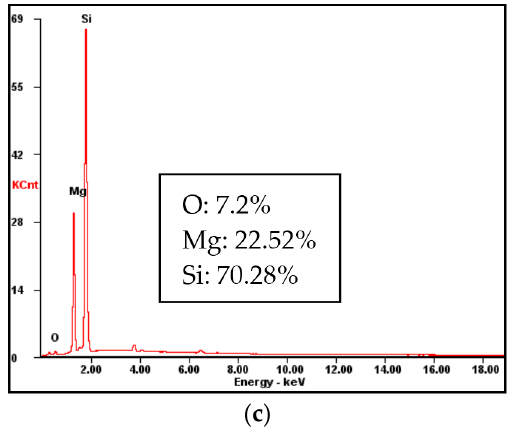
Figure 7. Energy dispersive X-ray spectrometry (EDS) atomic concentrations (wt %) on the surface of talc (without adding FPY) of different size fractions: ( a ) − 74 + 38 μ m, ( b ) − 38 μ m, ( c ) − 10 μ m.